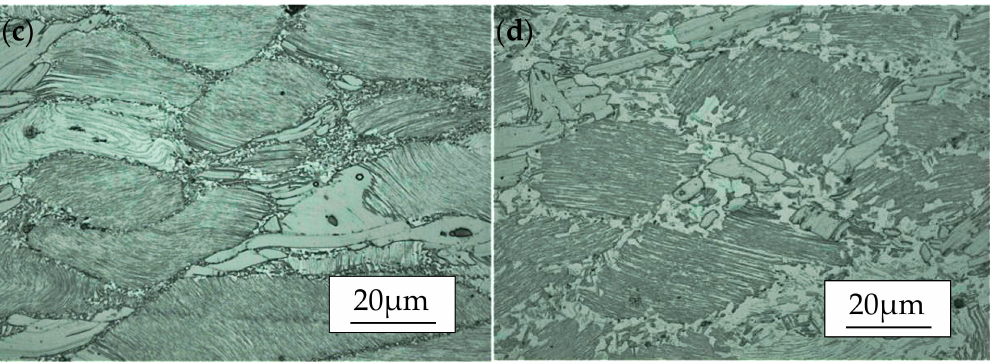
Figure 6. Microstructure image of the Mg-13.5Gd-3.2Y-2.3Zn-0.5Zr alloy compressed at the rate of 0.01/s and processing temperature of ( a ) 350 ◦ C, ( b ) 400 ◦ C, ( c ) 450 ◦ C, and ( d ) 500 ◦